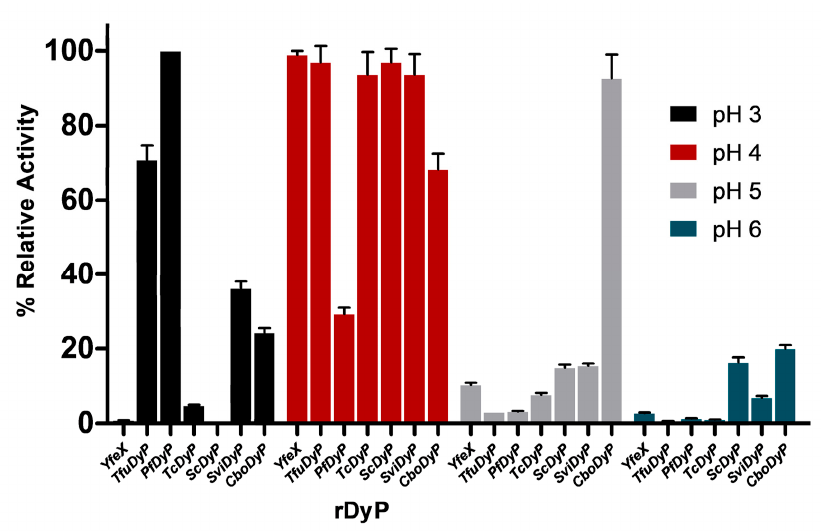
Figure 2. Activity profiles of the seven rDyPs obtained at four pH values using ABTS oxidation assay. [rDyP] = 75 nM, [ABTS] = 1 mM, [H 2 O 2 ] = 0.25 mM, universal buffer.